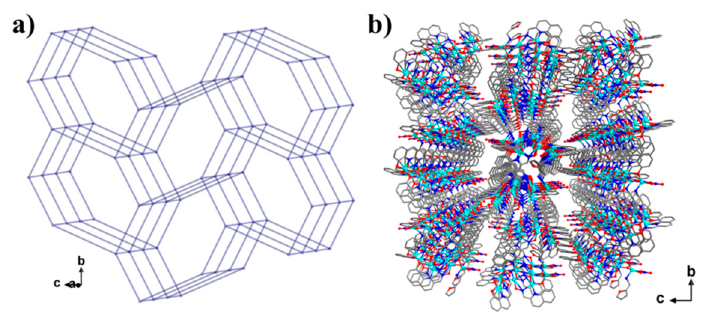
Figure 2. ( a ) The connecting modes of the clusters through the C–H ··· π , π ··· π interactions and hydrogen bonds in complex 1 ; ( b ) and its stacking mode.